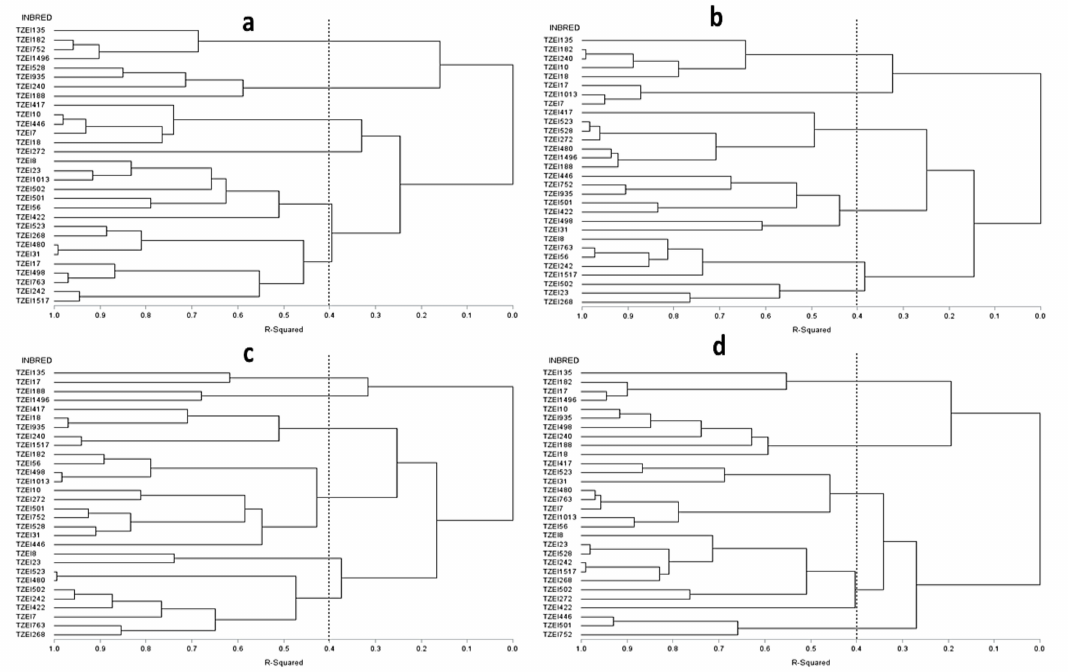
Figure 2. Dendrogram of 30 tropical maize inbred lines generated from Euclidean genetic distance- based GCA effect of grain yield and other traits (HGCAMT) using Ward’s minimum variance. ( a ) Un- der combined heat and drought environment ( b ) Under heat stress ( c ) Under terminal drought stress, and ( d ) Across environments. The imagery line indicate cut off point at 40% level of dissimilarity (R 2 =